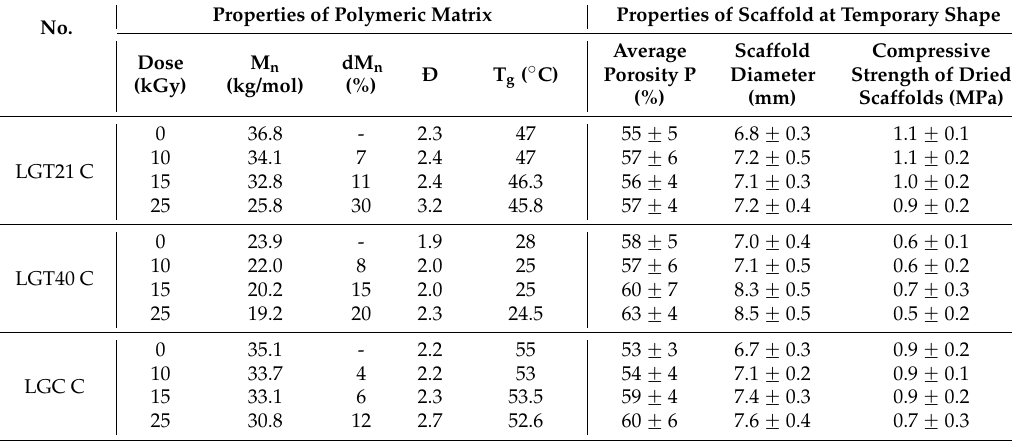
Table 3. Effect of absorbed dose of electron beam on properties of terpolymers and scaffolds at their temporary shape.